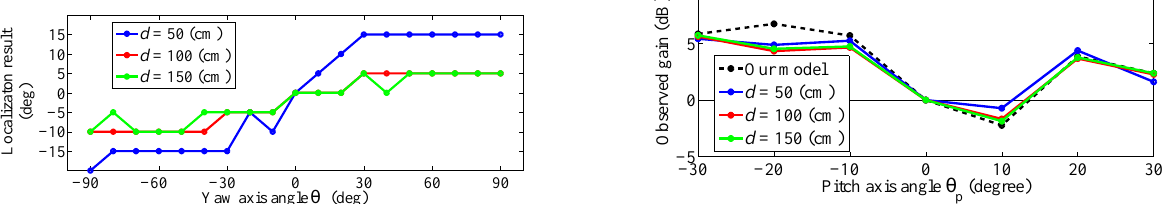
Figure 14. Sound localization result on the azimuth plane